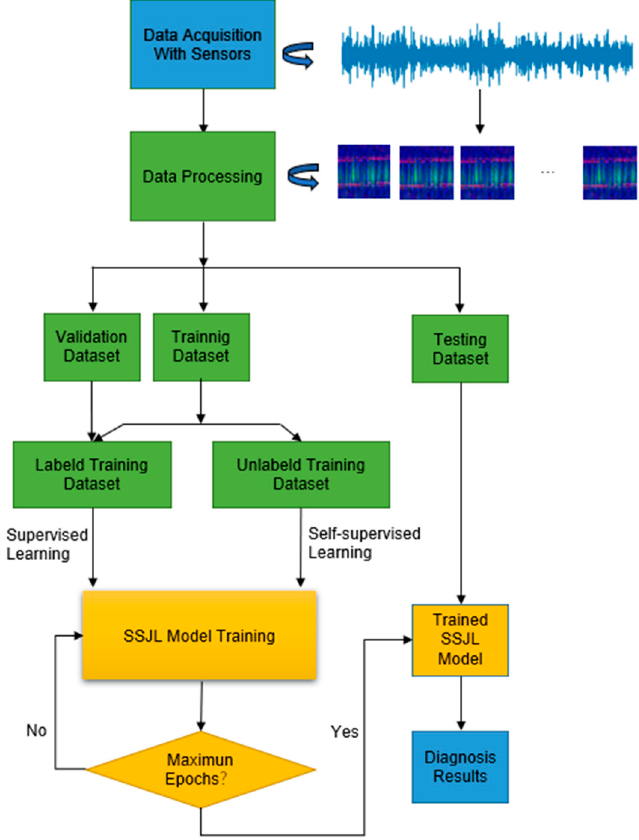
Figure 4. The flowchart of the SSJL method.